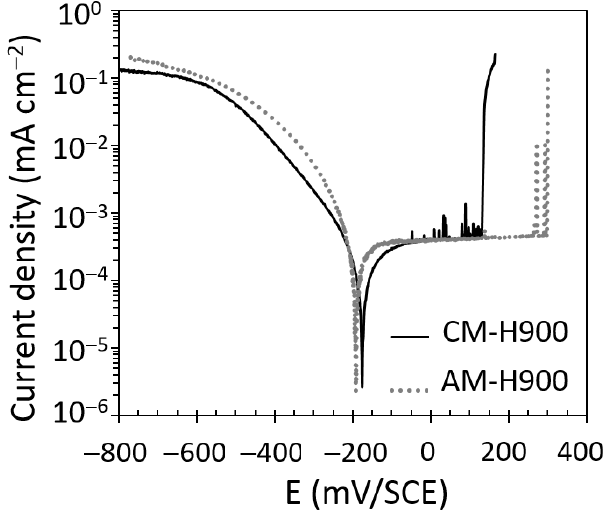
Figure 3. Polarisation curves plotted in 0.5 M NaCl solution for the AM and CM samples. Scan rate = 500 mV h −1 .